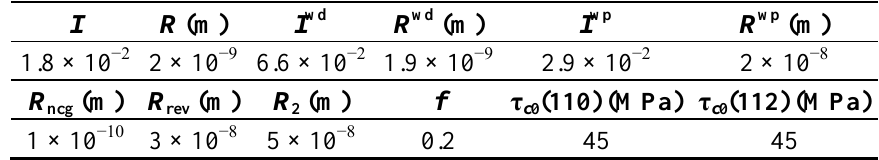
Table 1. Material model parameters identified for an interstitial-free (IF)–Ti steel.